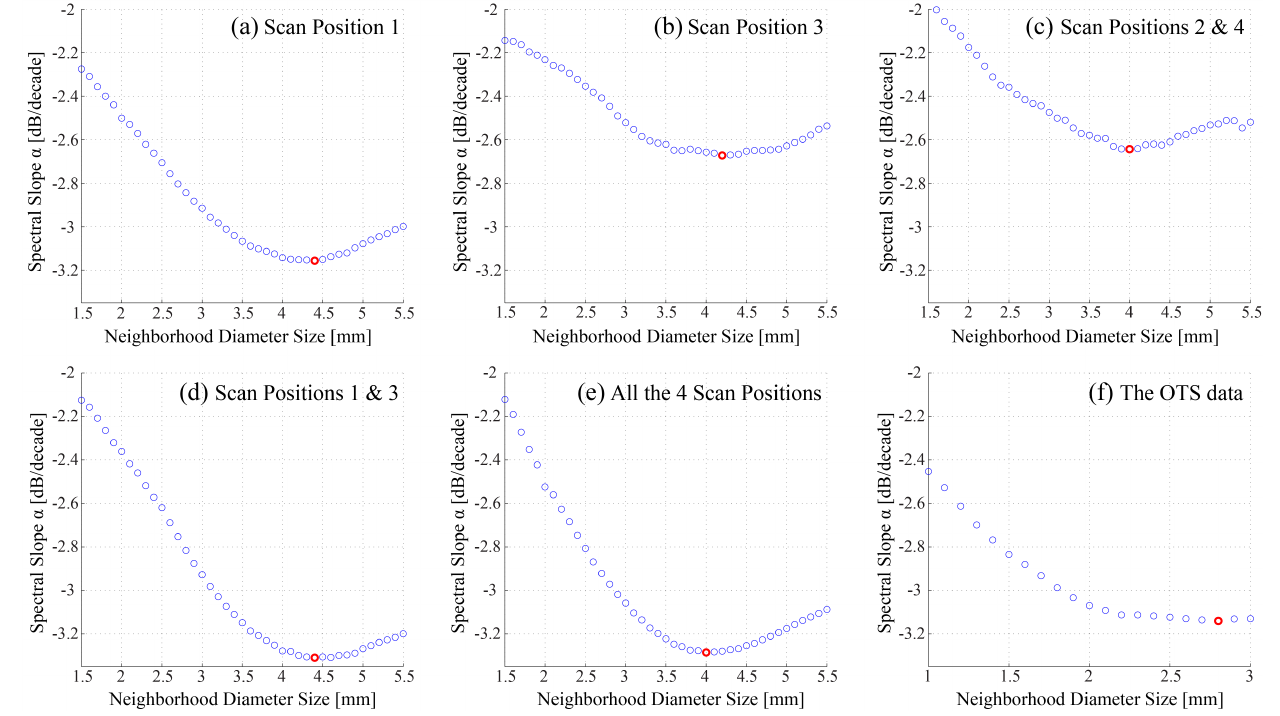
Figure 7. The local minima in the spectral slope calculated for: ( a ) DEM Set 2.1, ( b ) DEM Set 2.2 , ( c ) DEM Set 2.4, ( d ) DEM Set 2.3, ( e ) DEM Set 2.5 and ( f ) DEM Set